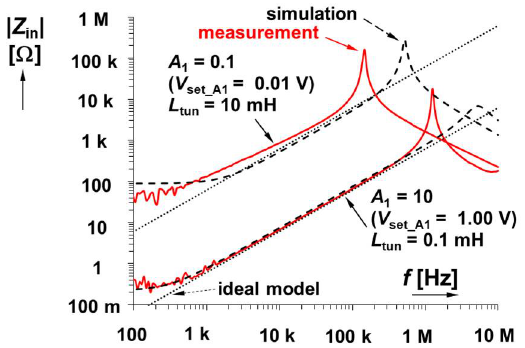
Figure 6. Magnitude impedance plots of solution presented in Figure 3.